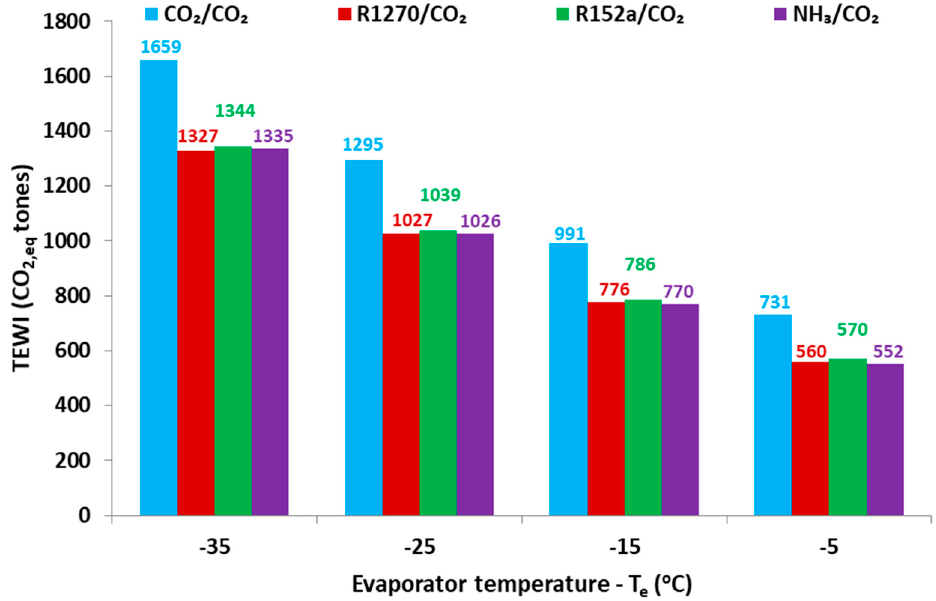
Figure 11. TEWI of four cases for different evaporator temperatures.